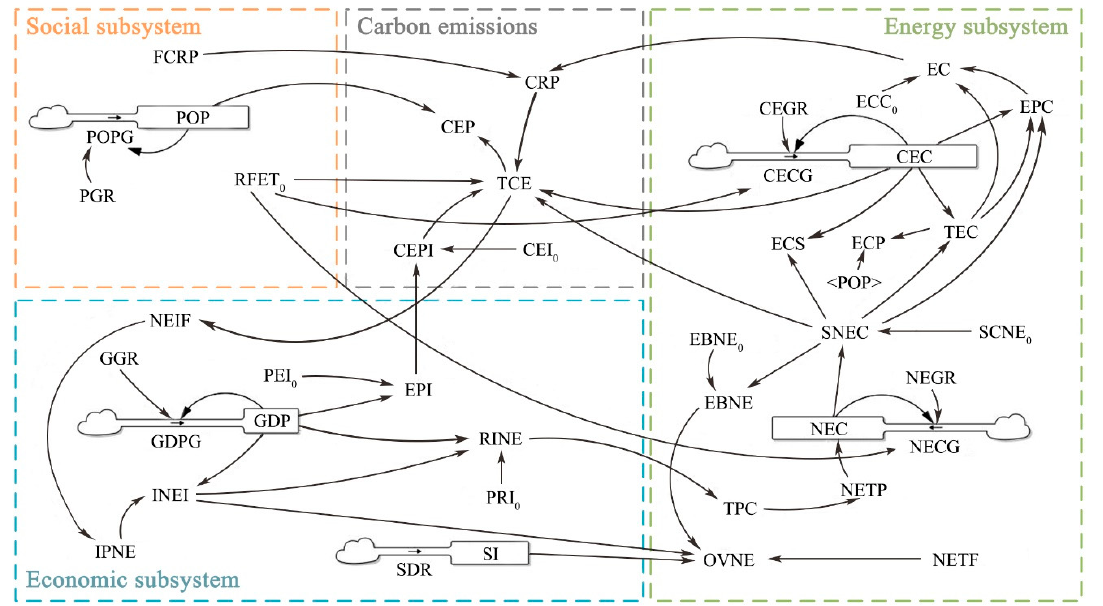
Figure 2. The SD Model for scenario analysis (POP: total population; CEC: conventional energy consumption; NEC: renewable energy consumption; SI: subsidy intensity; GDPG: GDP growth per year; POPG: population growth per year; CECG: conventional energy consumption growth per year; NECG: renewable energy consumption growth per year; SDR: subsidy decline rate; PEI 0 : proportion of environmental protection investment; PRI 0 : proportion of R&D; CEI 0 : coefficient of environmental protection investment; ECC 0 : environmental capacity coefficient; SCNE 0 : standard coefficient of renewable energy; EBNE 0 : economic benefit per unit renewable energy; RFET 0 : regulatory factors of energy tax; GGR: GDP growth rate; PGR: population growth rate; CEGR: conventional energy growth rate; NEGR: renewable energy growth rate; NETF: renewable energy tax factor; EPI: environmental protection investment; CEPI: CO 2 reduction by environmental protection investment; FCRP: factors of CO 2 reduction policies; CRP: CO 2 reduction by policies; TCE: CO 2 emissions; NEIF: renewable energy incentive factors; IPNE: investment proportion of renewable energy industry; INEI: investment of renewable energy industry; RINE: R&D investment in renewable energy industry; TPC: technological progress coefficient; NETP: added value of renewable energy brought by technological progress; SNEC: standard renewable energy consumption; EBNE: economic benefit of renewable energy; OVNE: output value of renewable energy; TEC: total energy consumption; ECP: energy consumption per capita; CEP: carbon emission per capita; EPC: energy pollution coefficient; EC: environmental capacity; ECS: energy consumption structure; EI: energy intensity).